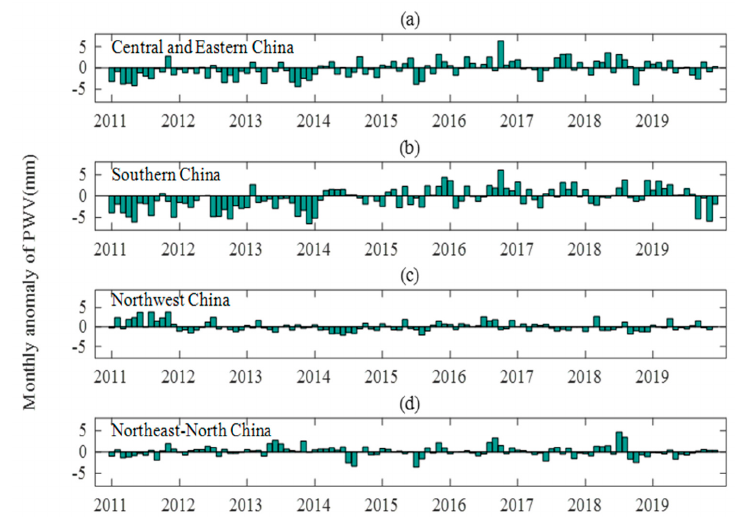
Figure 13. Monthly anomaly (mm) of the PWV in four regions of China.